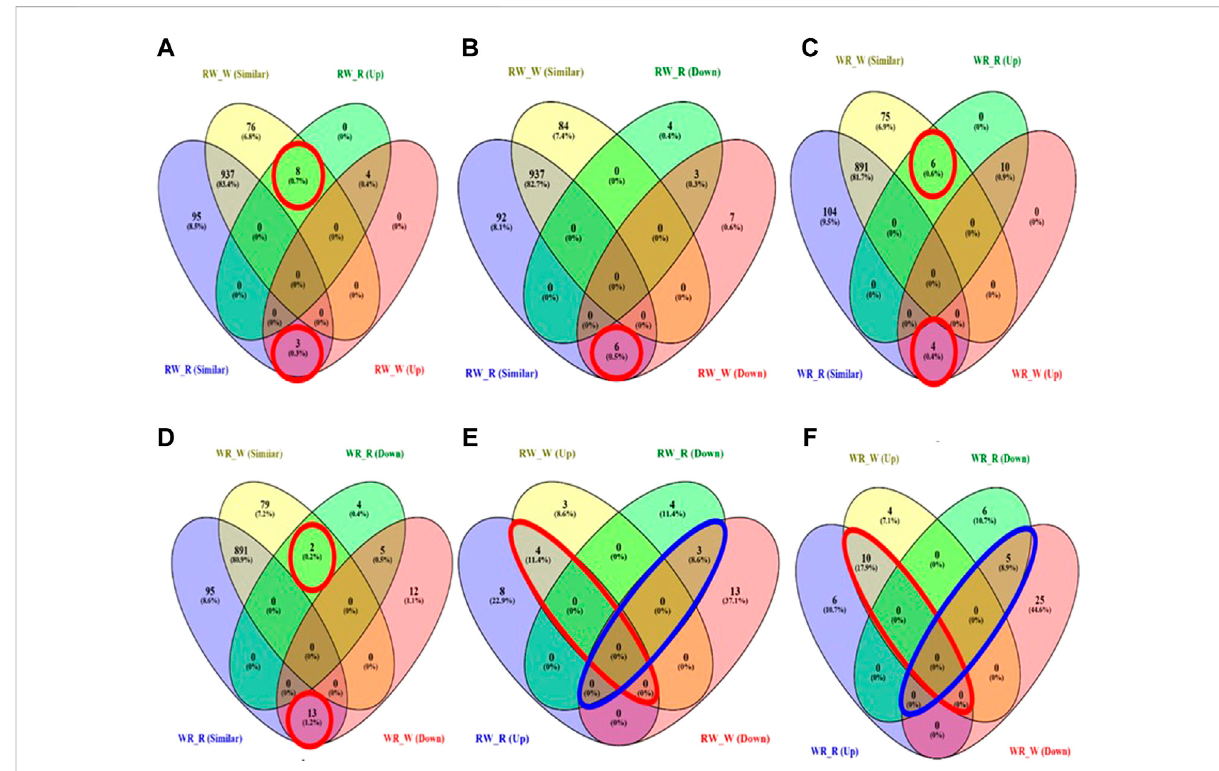
FIGURE 4 VenndiagramshowingDEMiRsaccordingtotheirpatternofinheritance (A) HighparentdominanceinRW (B) Low-parentdominanceinRW (C) High parent dominance in WR (D) Low-parent dominance in WR (E) Overdominance (enclosed in red) and underdominance (enclosed in blue) expression of miRNAs in RW (F) Overdominance (enclosed in red) and underdominance (enclosed in blue) expression of miRNAs in